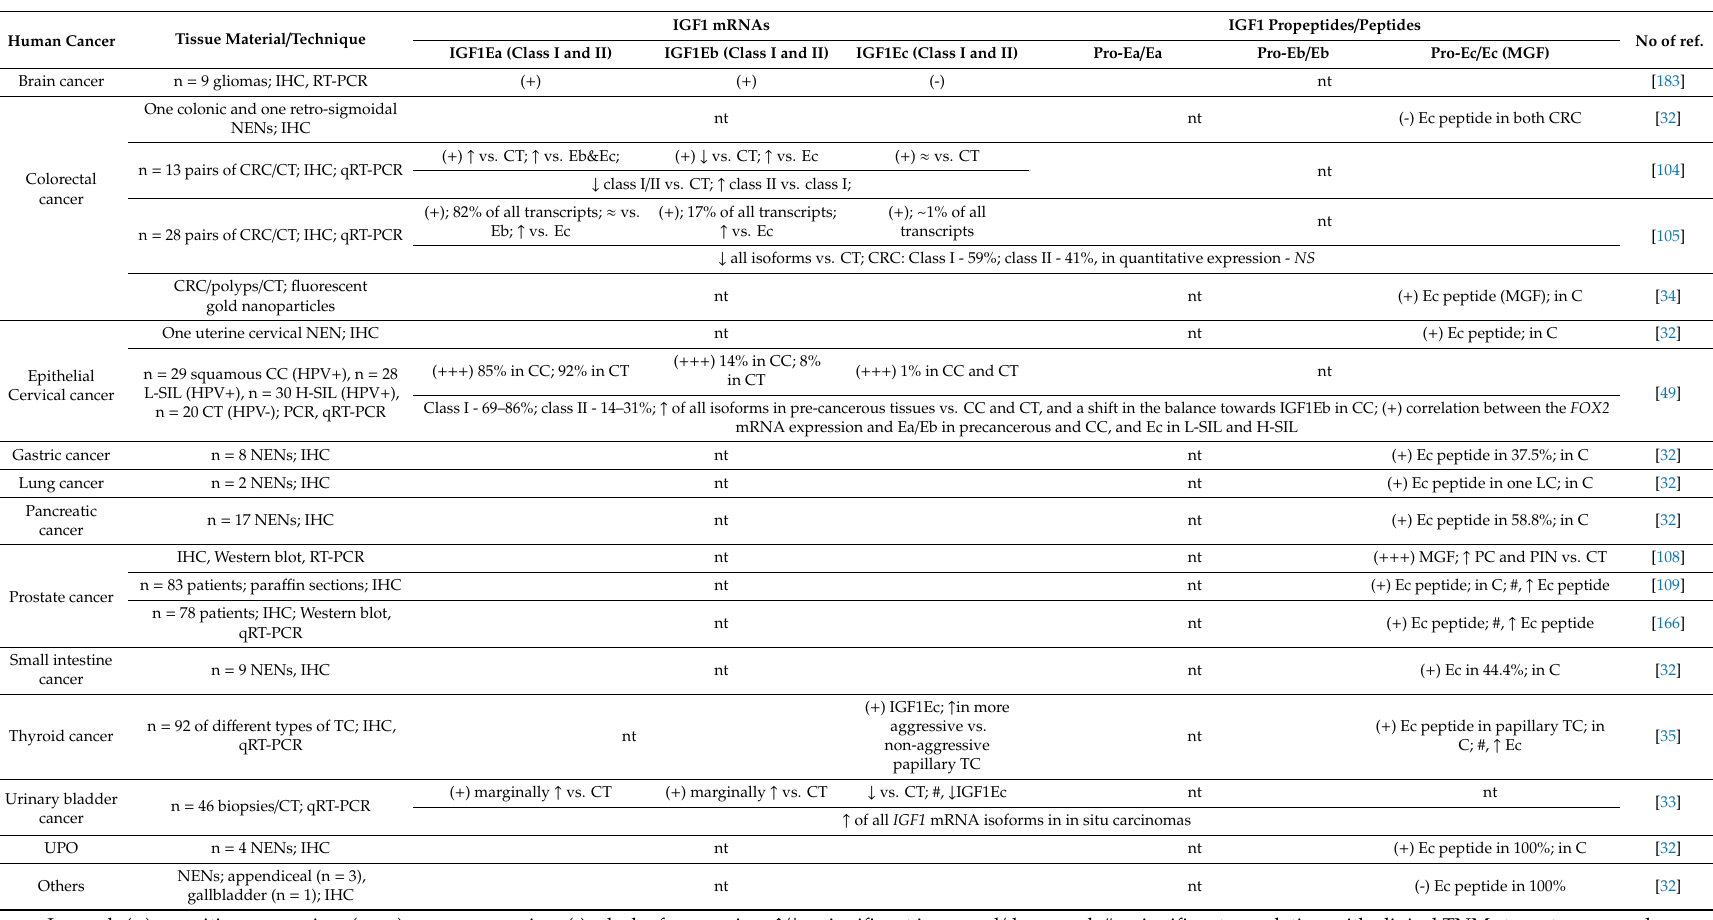
Table 1. In vivo expression of di ff erent IGF1 isoforms (mRNA, protein) in selected human